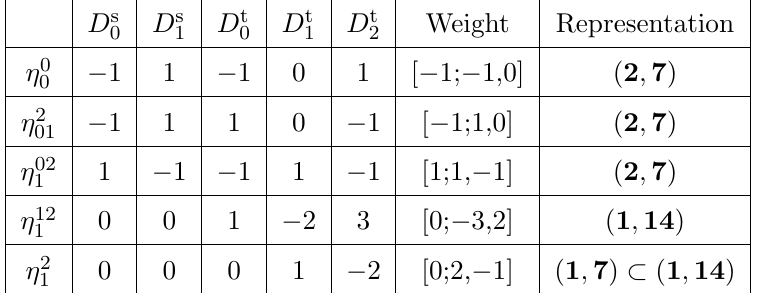
Figure 6 . Codimension-two Collision of SU(2) (cid:2) G type III (cid:3) (with dual graph e E 7 ) with contracted nodes.